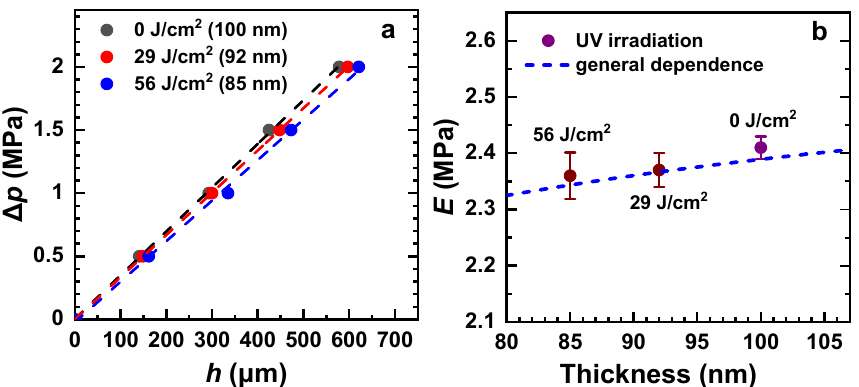
Figure 9. ( a ) ∆ p vs. h plots for the pristine and irradiated (UV light) PEG membranes (see the legend); a nearly linear dependence is tentatively traced by the straight lines. ( b ) Young’s modulus of these membranes as a function of the membrane thickness; the UV doses are marked; the blue dashed line represents the general E - t dependence for the pristine membranes (Figure 5). The window diameter was 1 mm.